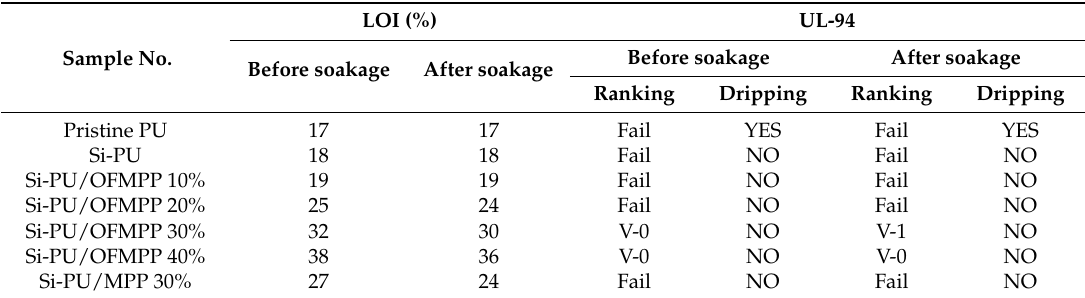
Figure 6. Residues after burning for 1 min: ( a ) pure PU; ( b ) Si-PU; ( c ) Si-PU/OFMPP 10%; ( d ) Si-PU/OFMPP 20%; ( e ) Si-PU/OFMPP 30%; ( f ) Si-PU/OFMPP 40% and ( g ) Si-PU/MPP 30%. Table 3. Flame-retardant properties of pure PU, Si-PU, Si-PU/MPP 30% and Si-PU/OFMPP 10–40% composites.